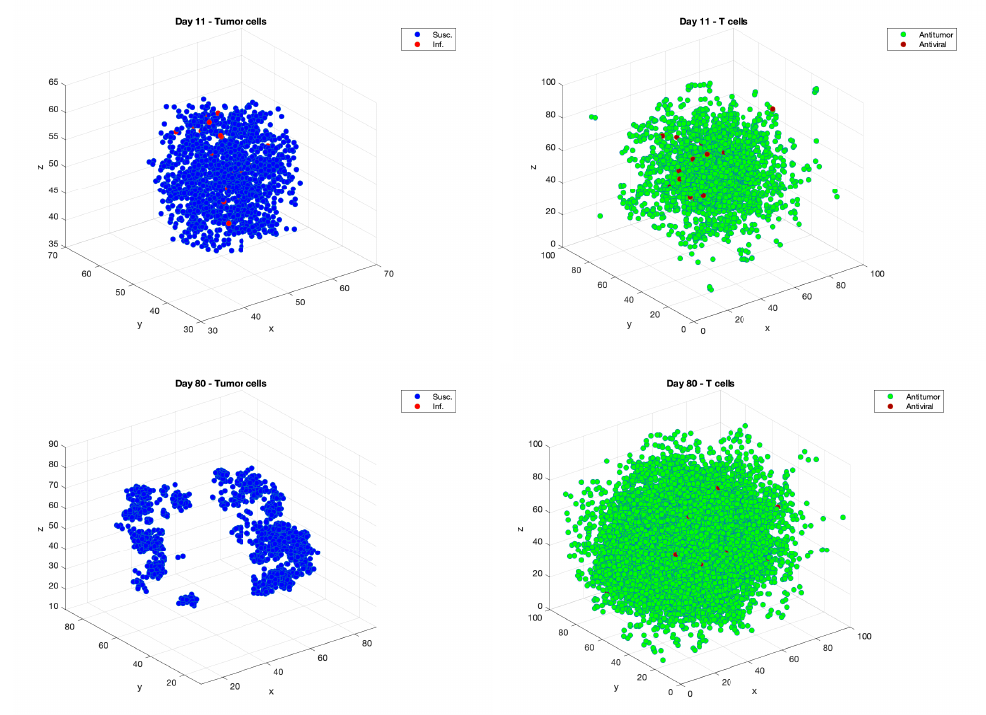
Figure 2. Examples of 3-D simulations plots of tumor cells and T cells on Day 11, immediately after Dose 2, in the top row, and on Day 80, at the end of the simulation, on the second row. On Day 11, there are 1.51 × 10 3 tumor cells and 1.44 × 10 4 T cells. On Day 80, there are 1.40 × 10 3 tumor cells and 5.83 × 10 4 T